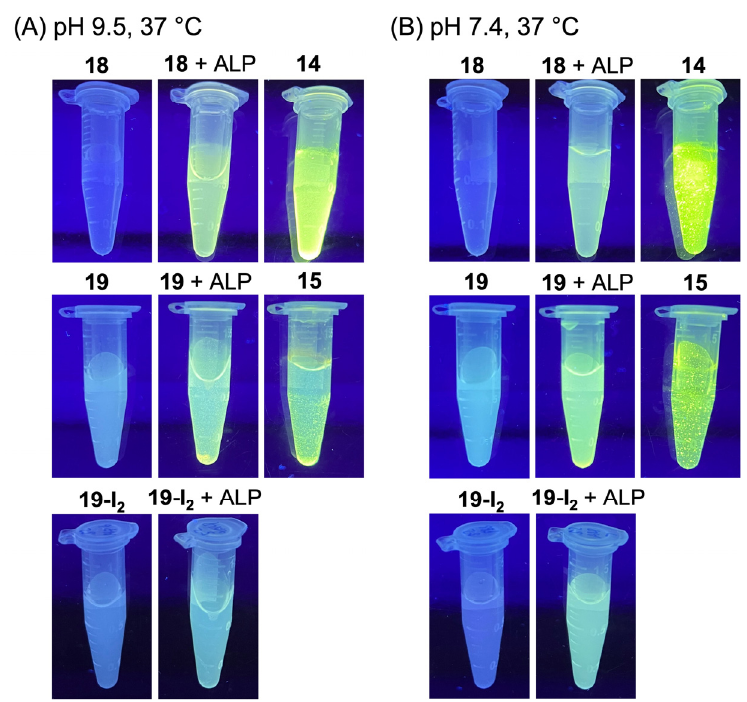
Figure 9. Visualization (UV illumination) of samples. ( A ) Treatment at pH 9.5 and 37 °C for 24 h. Left column—no enzyme with 18 , 19 , and 19-I 2 (20 μ M). Middle column—treatment of 18 , 19 , and 19-I 2 (20 μ M) with ALP (20 μ g/mL). Right column— 14 and 15 (20 μ M) in ALP buffer (positive controls). ( B ) Treatment under physiological condition (pH 7.4 and 37 °C) for 24 h. Left column—no enzyme with 18 , 19 , and 19-I 2 (20 μ M). Middle column—treatment of 18 , 19 , and 19-I 2 (20 μ M) with ALP (20 μ g/mL). Right column— 14 and 15 (20 μ M) in PBS buffer (positive controls).